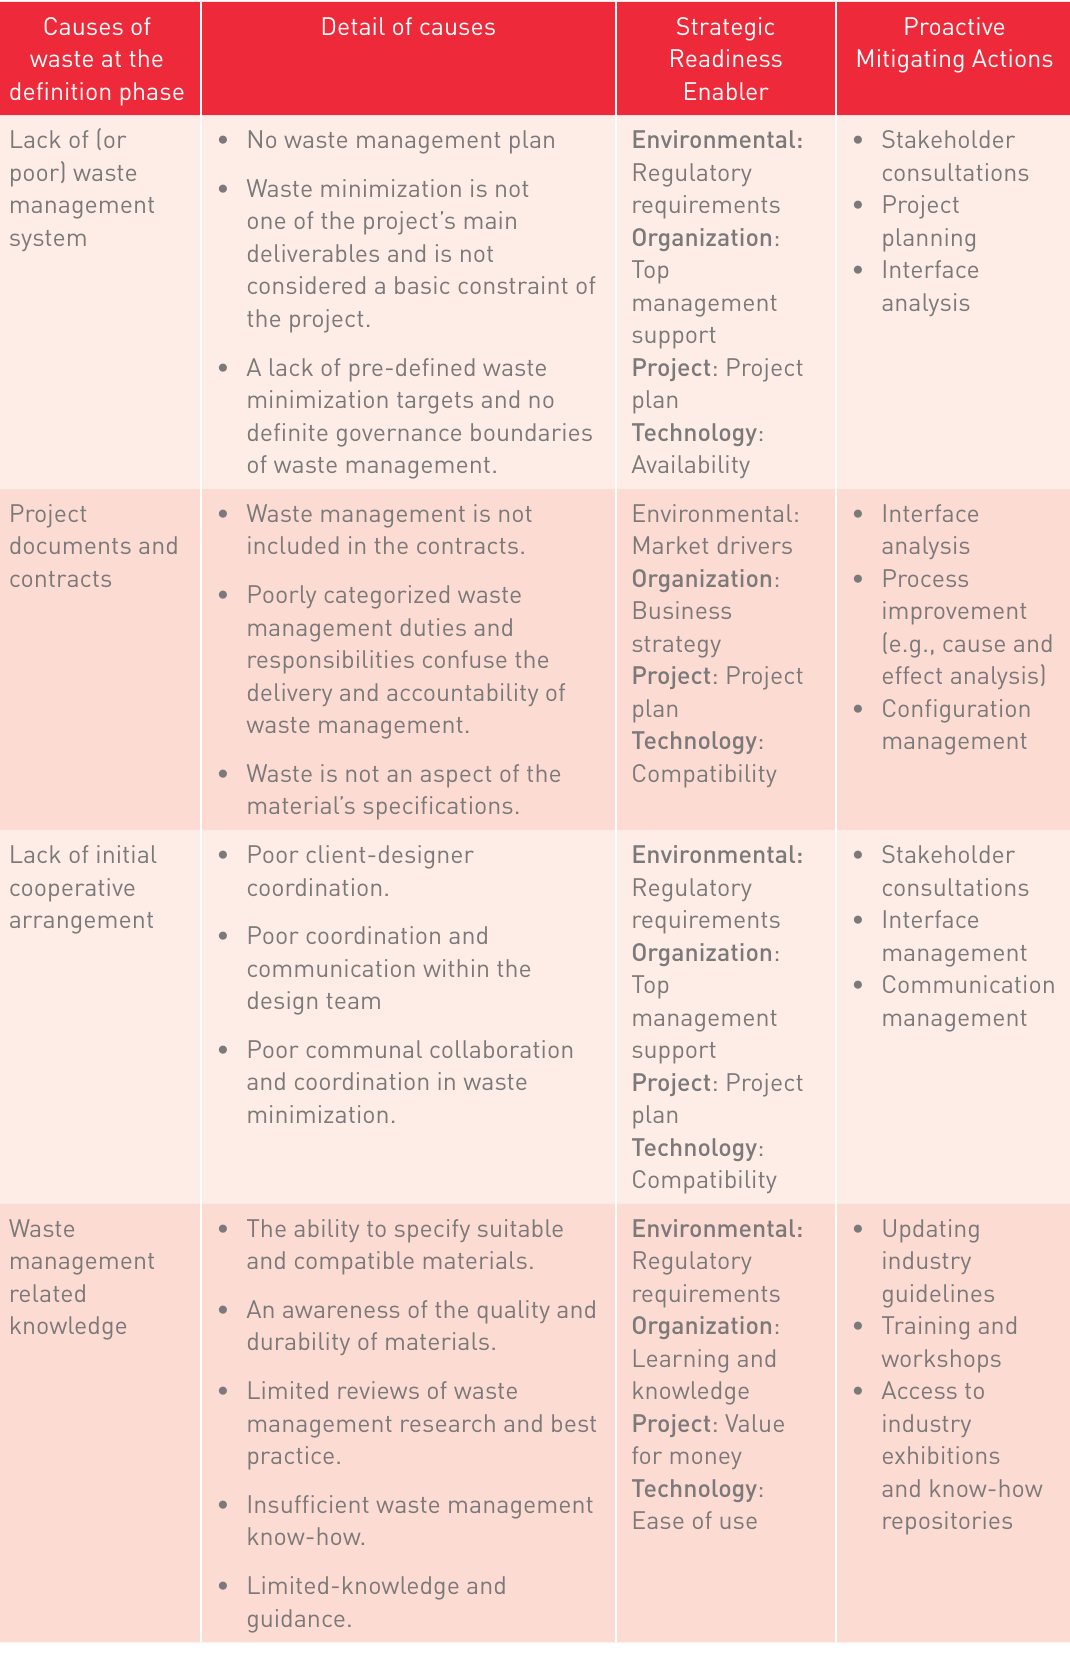
Table 5. The impactful causes of waste in the definition